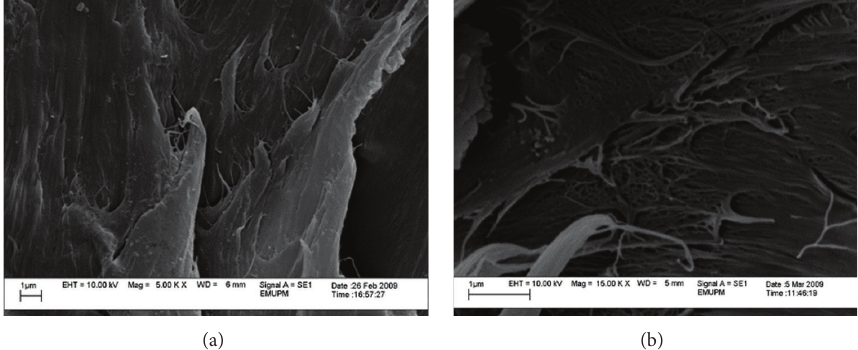
Figure 9: SEM micrograph of the fractured surface of PP/2% nano 𝛼 -Al 2 O 3 composites (a) in the presence of dispersant and (b) in the absence of